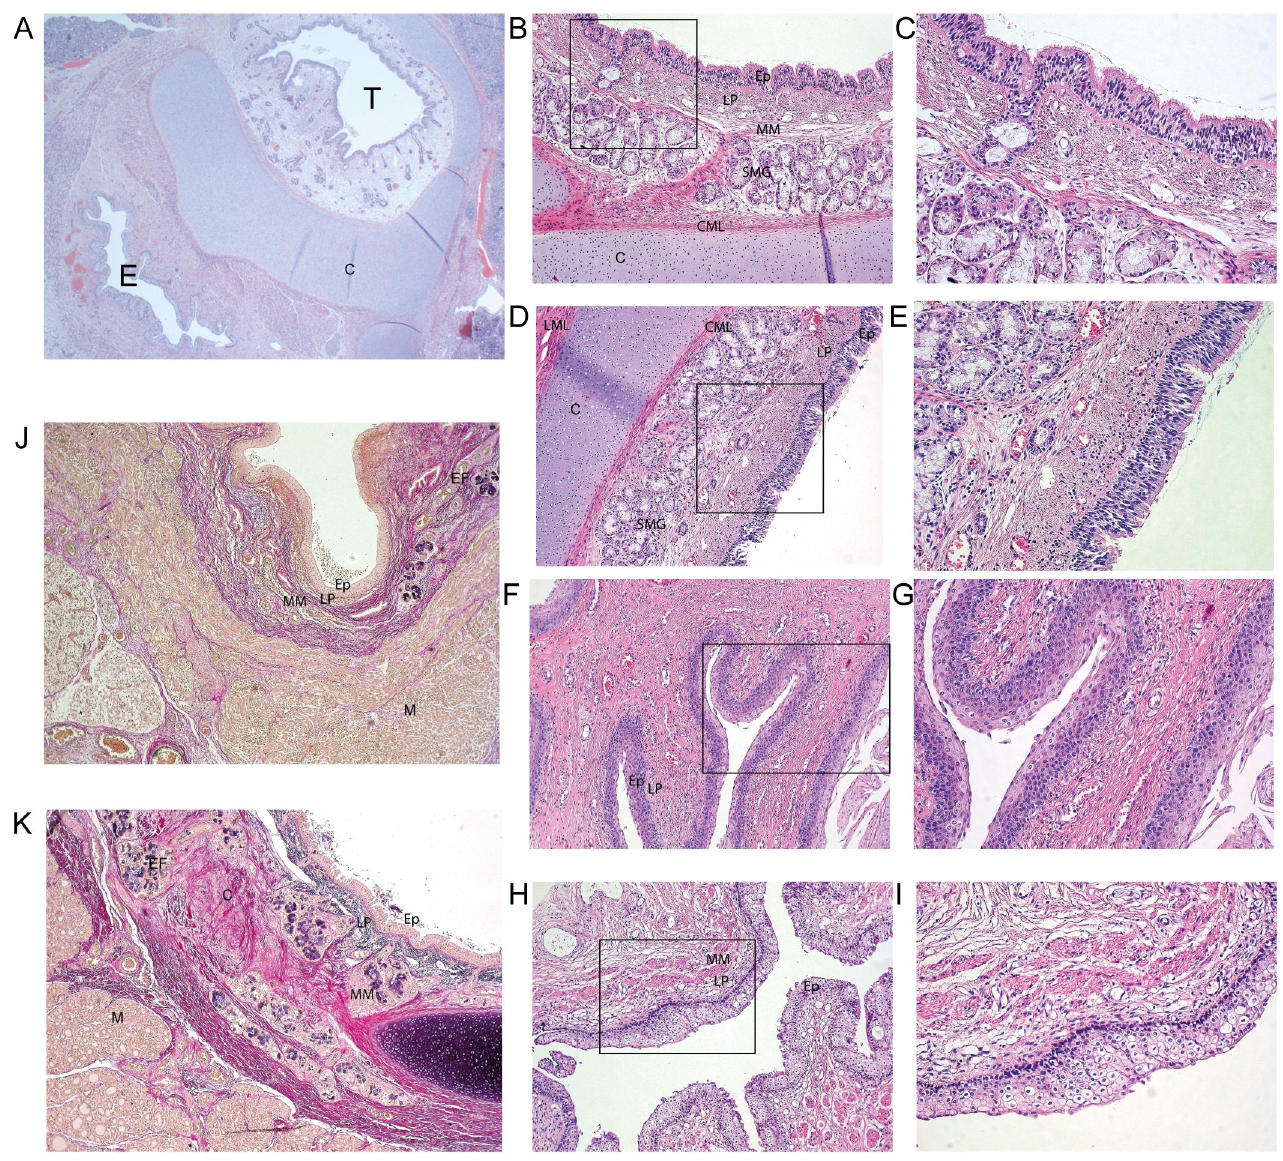
Fig 1. A-E. Hematoxylin and eosin (HE) stained sections of normal esophagus and trachea. A. Cross section of normal esophagus (E) and trachea (T) with surrounding cartilage (C) at 1.25 x magnification. B-C. Overview and detail of normal trachea with multilayered cylindrical epithelium (ep), underlying lamina propria (lp), muscular layer (mm) and seromucinous glands (smg); at the bottom of the image, the circular muscular layer (cml) and underlying cartilage can be seen. (at 10x (left) and 20x (right) magnification) C-D. Overview and detail of normal trachea covered with multilayered cylindrical epithelium (ep), with underlying glands, circular (cml) and longitudinal muscle layer (lml), both next to cartilage. (at 10x (left) and 20x (right) magnification) F-G and H-I. Normal esophagus covered by multilayered squamous epithelium (ep). (at 10x (left) and 20x (right) magnification) J and K. Elastic stain with elastic fibers in black (EF), collagen in pink (COL) and muscle (M) in yellow. In J an overview of normal esophagus is seen, with normal trachea in K. (at 4x